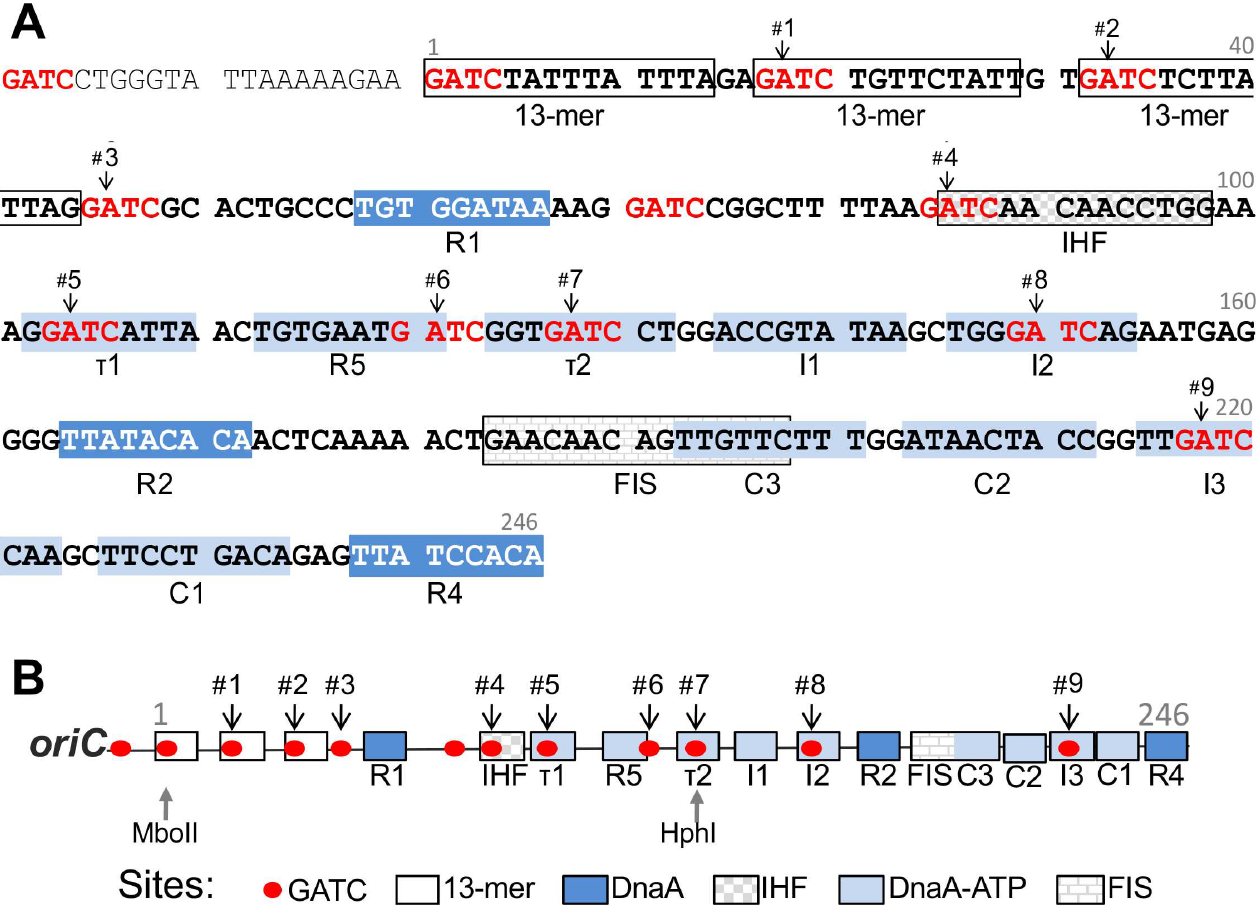
Fig 1. Sequence of oriC showing its major protein binding sites. (A) Sequenceof oriC that includesthe minimalregion(coordinates1–246) requiredfor origin function. The coordinate1 correspondence to 3923744 of gb|U00096.3|. The region includesseveralGATC sites (shown in red) which are methylatedby the Dam methylase enzyme. There are three 13-mer repeats of AT rich sequenceswhere the origin initiallyunwinds.The remainderof the origin has mainly 9-mer DnaA bindingsites as well as sites for bindingIHF and FIS proteins. DnaA sites have either high (R1, R2 and R4) or low ( τ 1, R5, τ 2, I1, I2, C3, C2, I3 and C1) affinity for DnaA. The numbers #1–9 mark the GATC sites studied here. A TaqI site (TCGA) overlappingeach of the nine GATC sites was created by convertingtheir two upstream bases to TC (NNGATC to TCGATC). (B) A linear map of oriC features describedabove. The map also shows location of sites for restriction enzymes MboII and HphI that naturallyoccurs in oriC